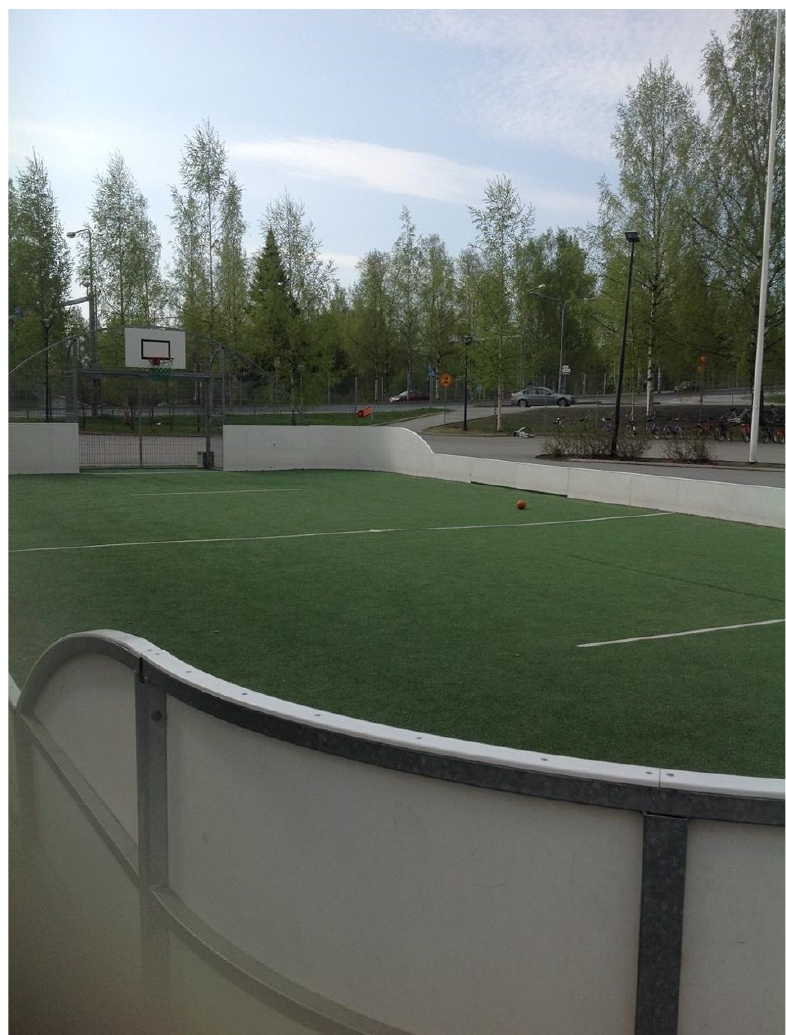
Figure 2. Outdoor mini-stadium.